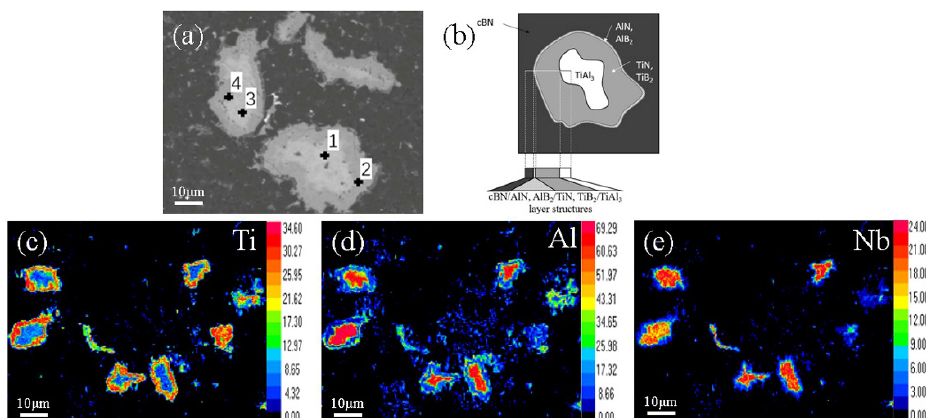
Figure 4. Microstructure and phase analysis of cBN composites: ( a ) 15 μ m, ( b ) EDS of the line in ( a ),